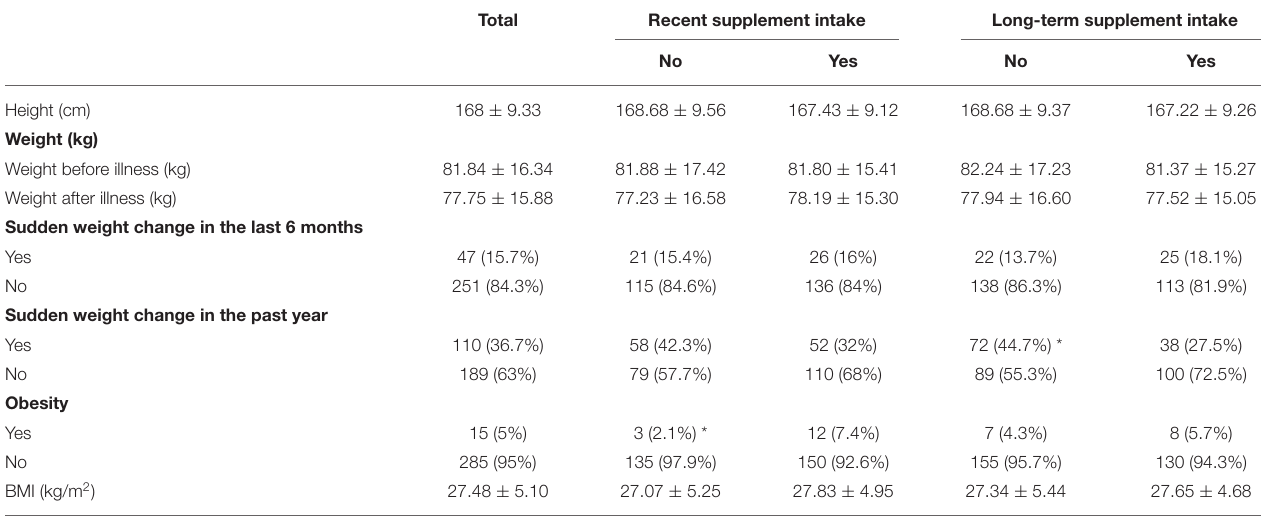
TABLE 2 | Anthropometric and obesity characteristics of patients with COVID-19.